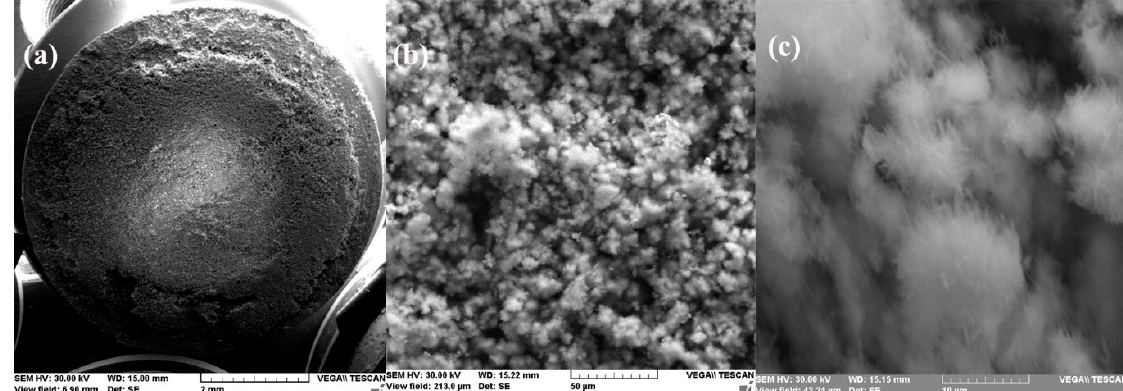
Figure 7. SEM microphotographs for C45 immersed 85 days in seawater ( a ) 100×, ( b ) 1000×, and ( c ) 5000×.